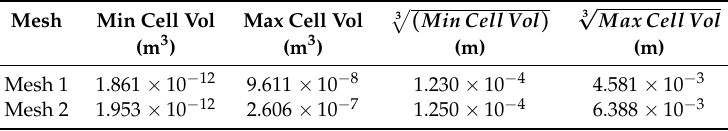
Table 4. Mesh scale analysis of mesh 1 and mesh 2.